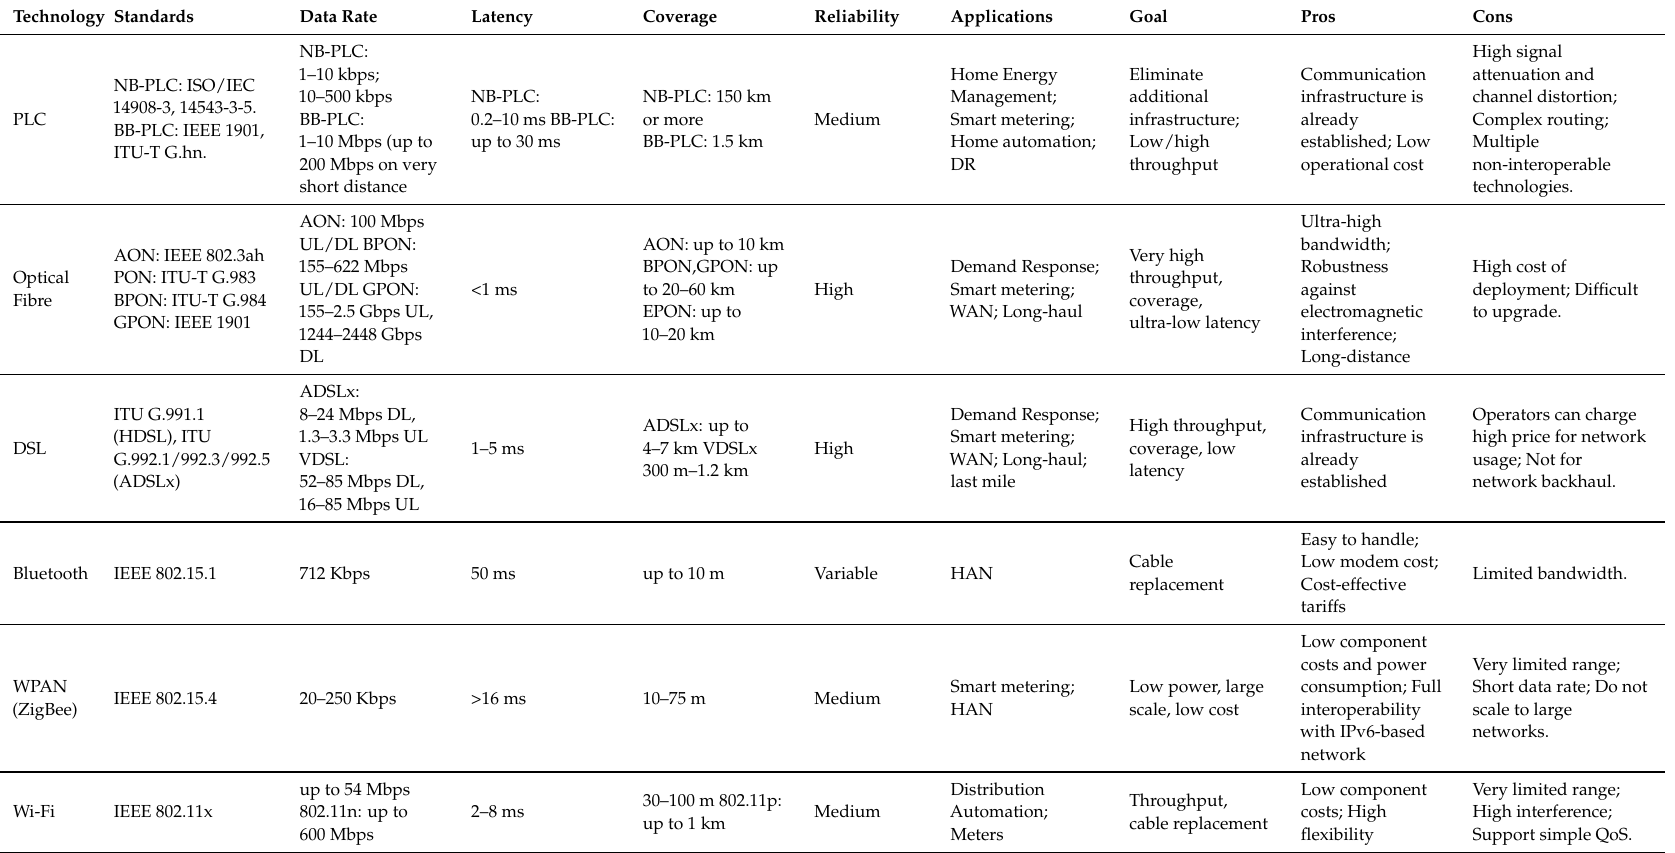
Table 1. Communication technologies and requirements in microgrids [23,44–46,50,51]. PLC: power line communication; DSL: digital subscriber line; WPAN: wireless personal area network; NB: narrowband; BB: broadband WiMAX: worldwide interoperability for microwave access; ITU-T G.hn: international telecommunication union-T home networking standard; AON: active optical network; PON: passive optical network; BPON: broadband PON; GPON: gigabit PON; UL: uplink; DL: downlink; TDD: time division duplex; FDD: frequency division duplex; UMTS: universal mobile telecommunication systems; HSPA: high speed packet